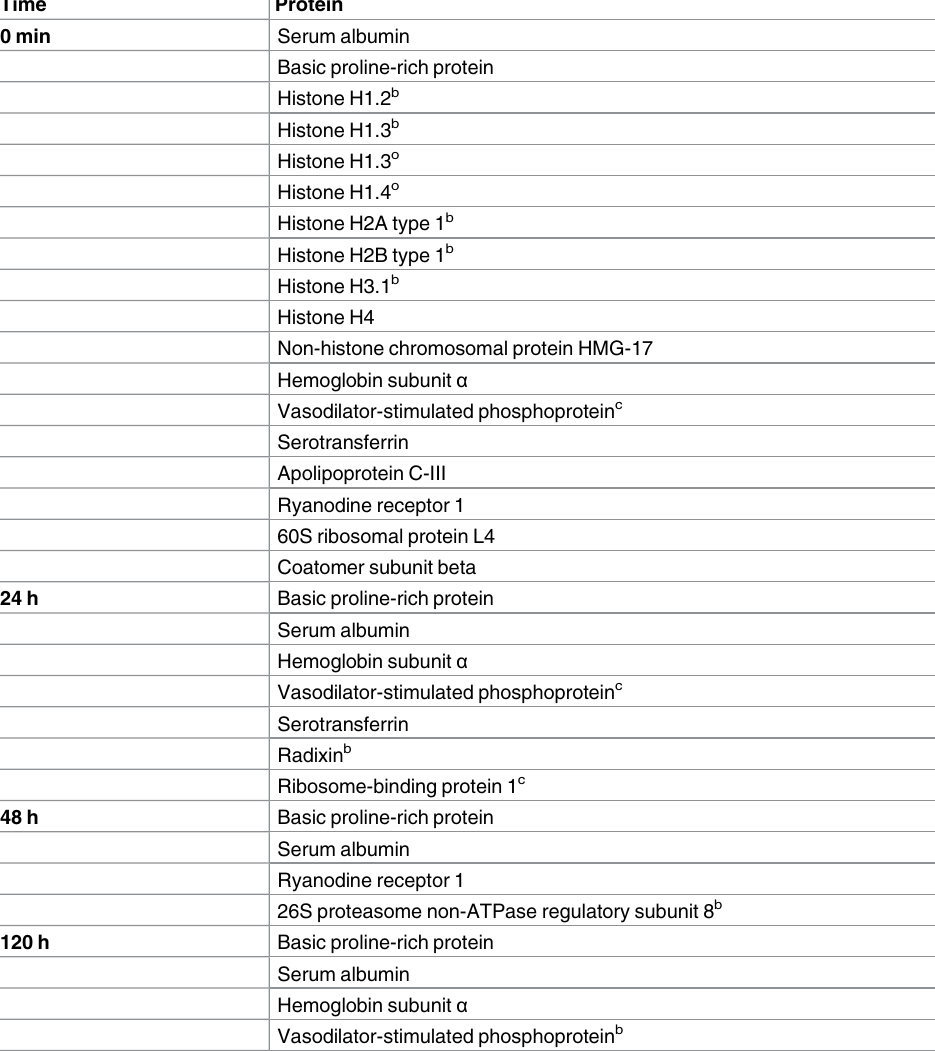
Table 2. Swine Plasmapeptides after PHx detected by magnetic bead-based LC-MALDI-TOF/TOF MS